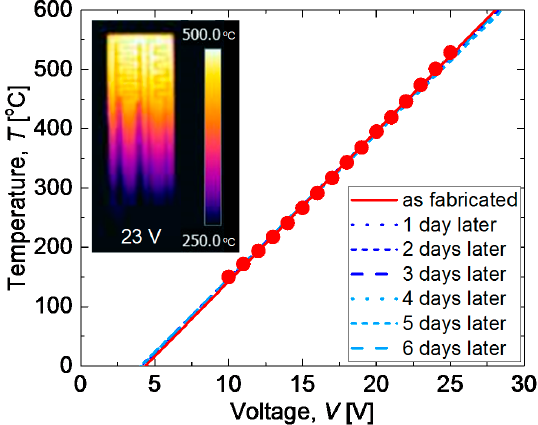
Figure 4. Sensor temperature ( T ), defined as the average temperature of the comb-type electrode, in air as a function of the voltage ( V ) applied to the heater. The closed circles represent the measured data just after fabrication. Solid line is linear fitting result for the closed circles. Dashed lines are fitting lines to the measurement results of each day after maintaining the voltage application of 23 V or more for 24 h.